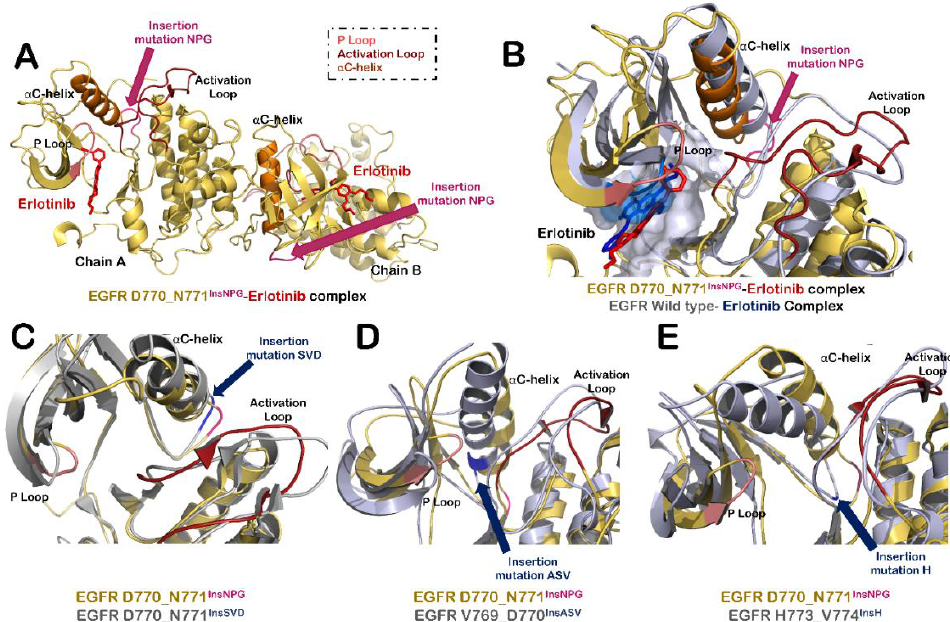
Figure 2. Structural modifications in EGFR protein due to insertion mutations in exon 20. ( A ) Structure of EGFR dimer having D770_N771 InsNPG mutation in complex with erlotinib. Insertion mutation is highlighted in pink color. Other highlighted structural elements around ATP binding site of protein include activation loop (shown in firebrick red color), α -C helix (orange) and P loop (salmon). ( B ) Superimposed structure of ATP binding site of Chain A of wildtype EGFR- erlotinib complex (grey-blue) with that of EGFR D770_N771 InsNPG –erlotinib complex (yellow-red). ( C )